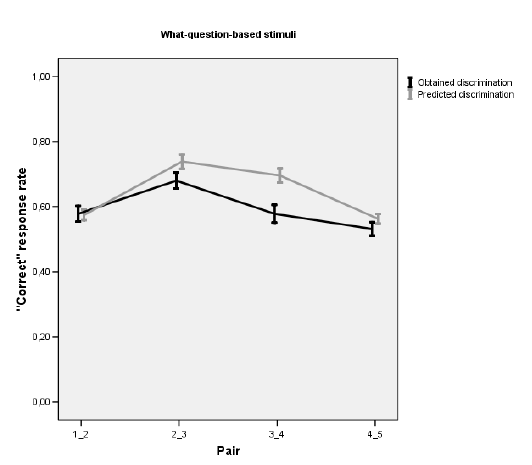
Figure 9. Predicted and obtained discrimination rates for the continuum created from the what-question base stimulus. Error bars represent the standard error of the